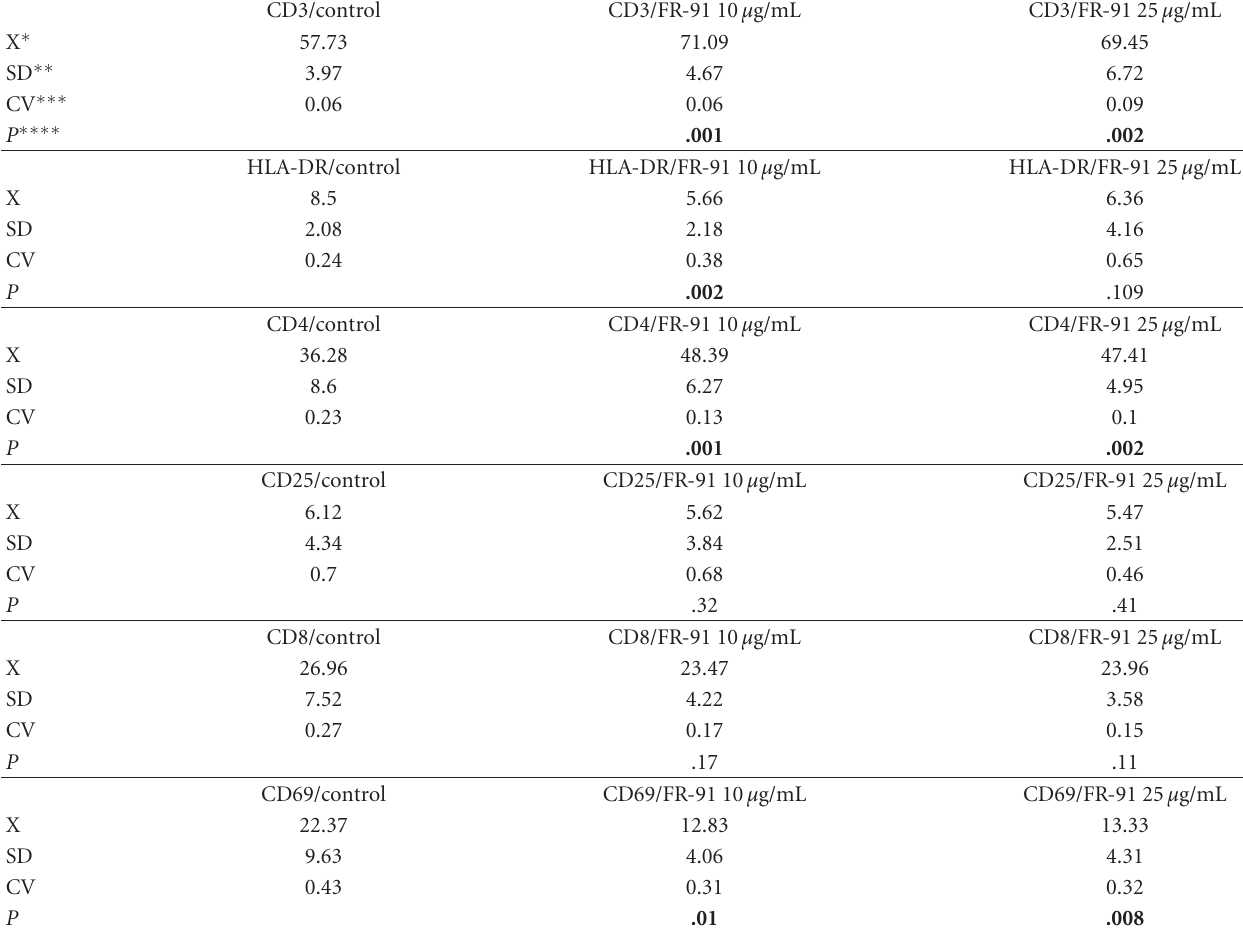
Table 2: E ff ect of FR-91 on peripheral blood mononuclear cell (PBMC) subsets from NHL patients.